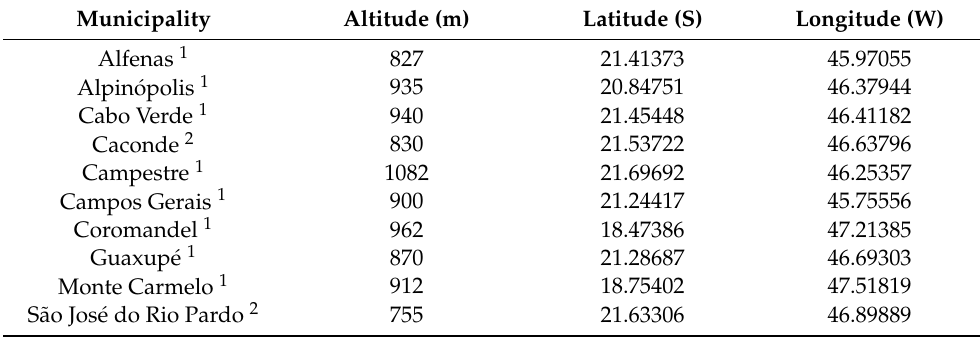
Table 4. Distribution of areas with meteorological stations for the validation of models of the coffee rust prediction system in 10 municipalities in the states of Minas Gerais and S ã o Paulo, Brazil. Municipality Altitude (m) Latitude (S) Longitude (W) Alfenas 1